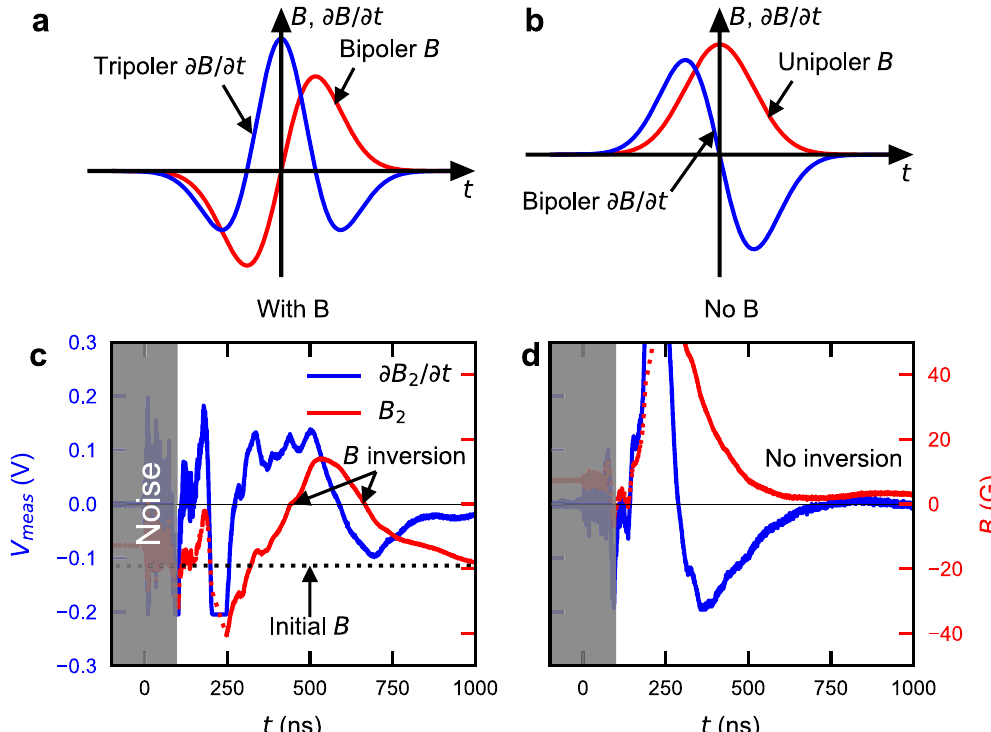
Figure 4. Local magnetic field inversion associated with plasmoid. ( a,b ) A schematic illustrating the relation between magnetic field ( B in red) and time derivative of magnetic field ( ∂ B /∂ t in blue) in bipolar and unipolar magnetic field, respectively. When the sign of magnetic field inverts ( a ), the signal of ∂ B /∂ t is tripolar. On the other hand, when a Biermann magnetic field approaches and passes through the probe ( b ), the signal of ∂ B /∂ t is bipolar. ( c,d ) Magnetic field measurements with and without the applied magnetic field in case2, respectively. The plots show the B 2 component where the magnetic field inversion is most significant. The blue and red curves represent the measured voltage and magnetic field, respectively. The velocity of fast plasma is ∼ 500 km/s 7 , thus, the signal before 100 ns is attributed to be the electromagnetic noise. This region ( t < 100 ns ) is shaded gray. The voltage curves at t ∼ 200 ns briefly saturate. The magnetic field before the saturation is expressed as dotted red curves and our analysis likely underestimates the B 2 magnetic field before saturation. The dotted and solid horizontal lines represent the initial magnetic field strength and B = 0 , respectively. The voltage returns to 0 at the end of the trace. We integrate the signals from the end of time to avoid problems caused by noise and saturation at times before ∼ 250 ns